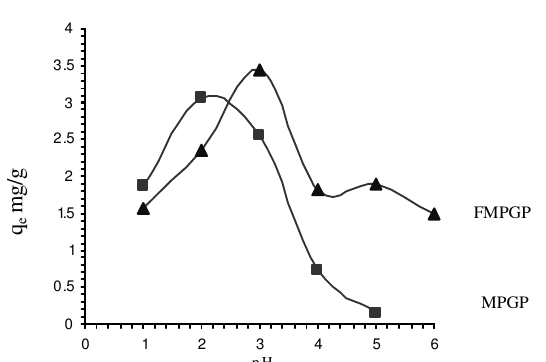
Figure 1 . Effect of PH on the adsorption of Cr(VI),10 mg/L, onto MPGP and FMPGP, 0.1g/50 mL.